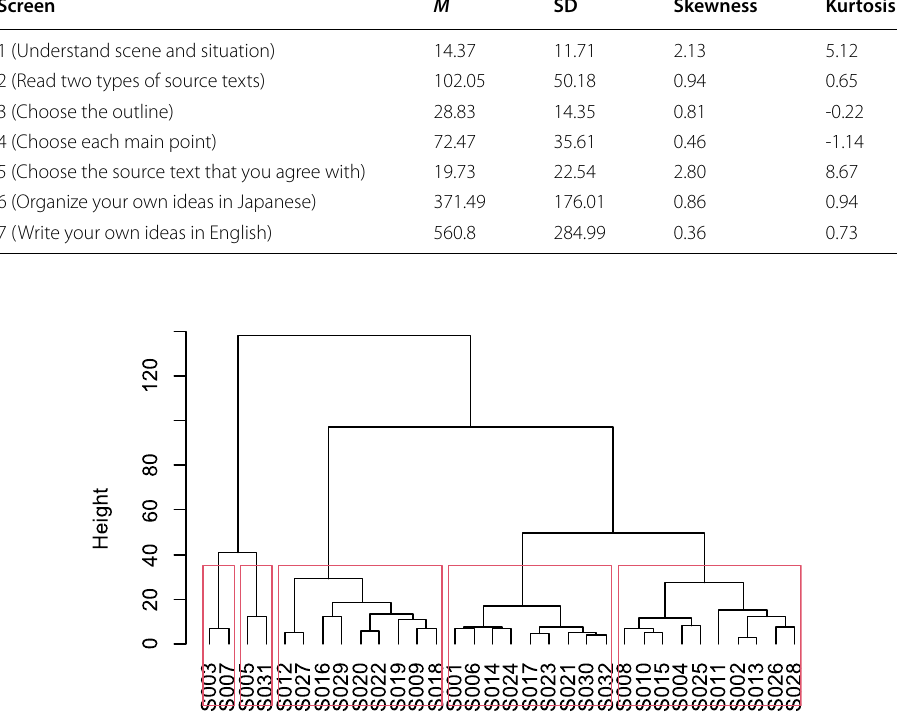
Table 7 Descriptive statistics of students’ RTs (in seconds) on each screen ( N Screen M SD Skewness